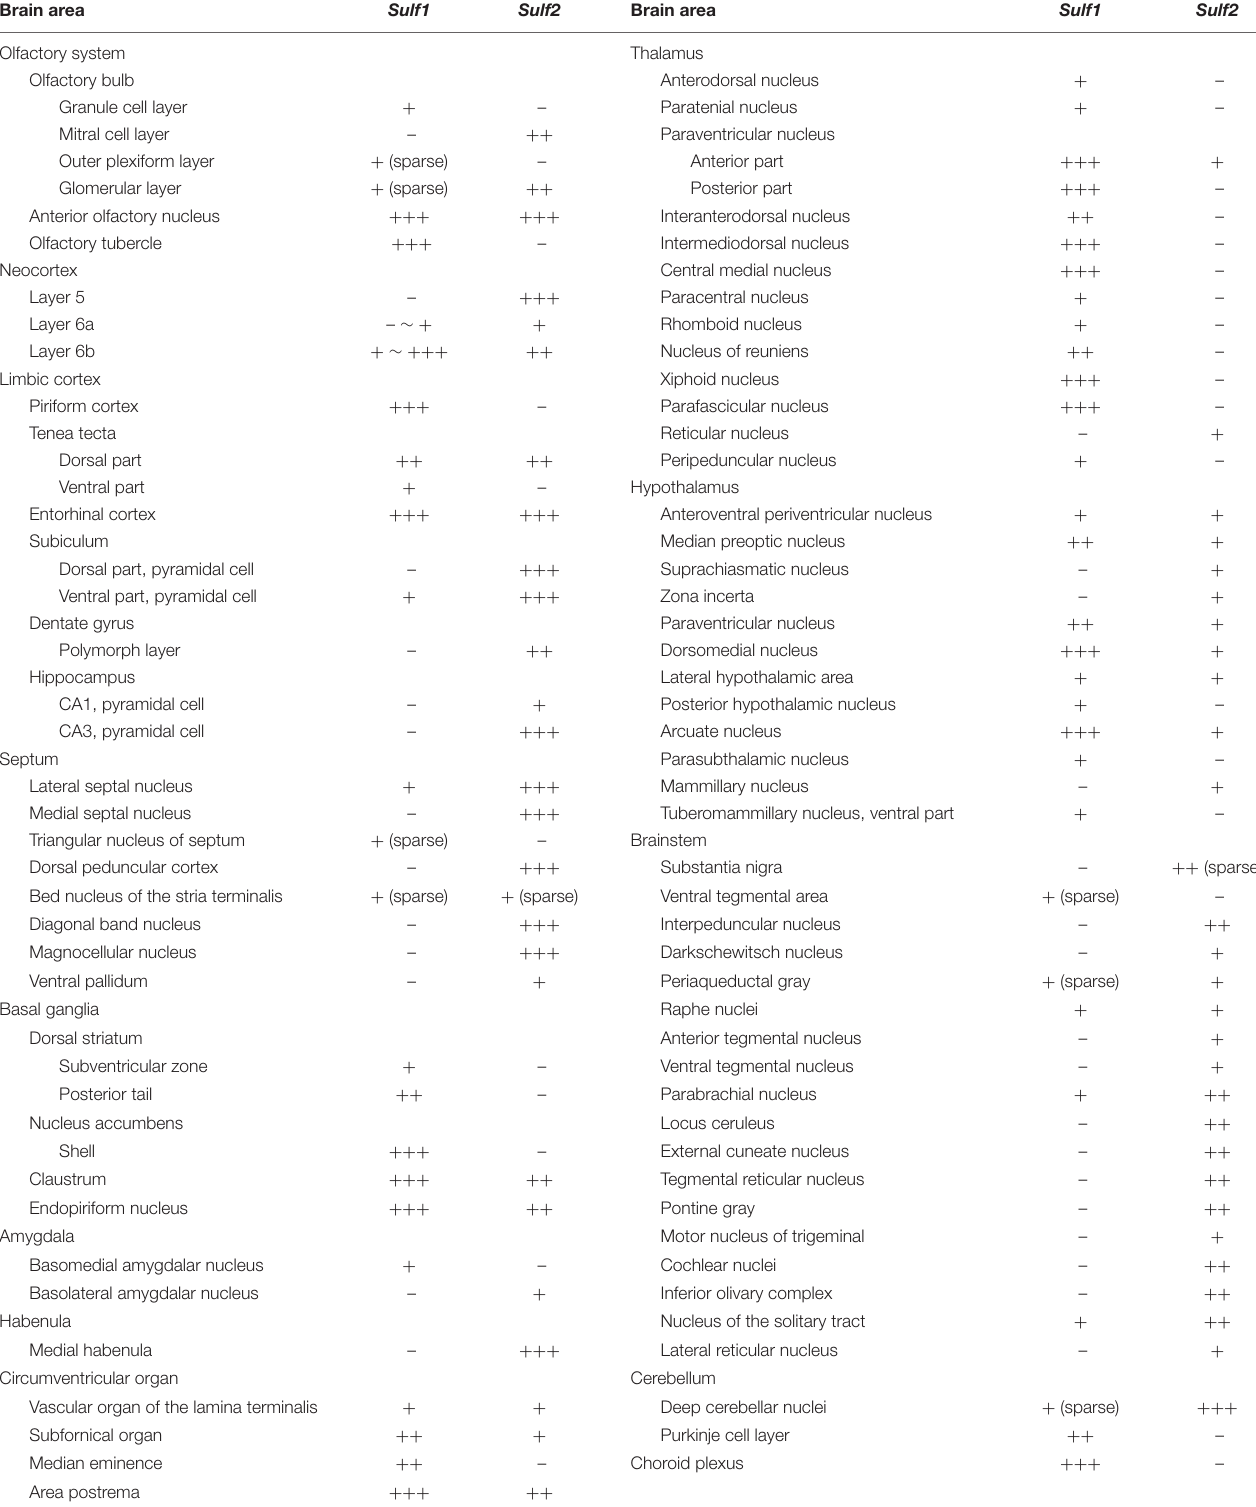
TABLE 1 | Expression of Sulf1 and Sulf2 in the adult mouse